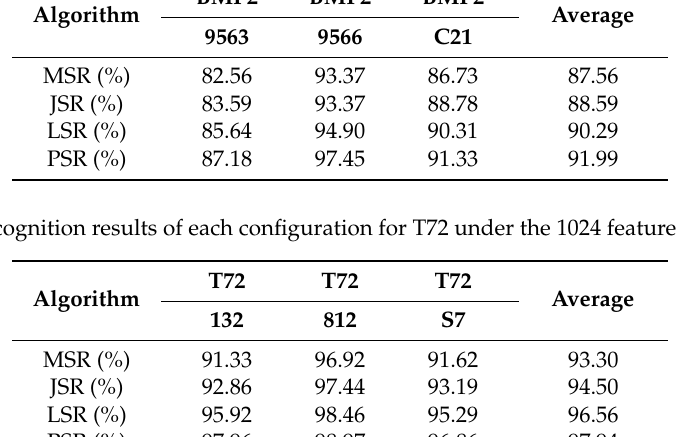
Figure 3. The probability of a recognition error under the different algorithms with different dimensionalities. ( a ) BMP2 configurations; ( b ) T72 configurations. Table 6. The recognition results of each configuration for BMP2 under the 1024 feature dimensionality.